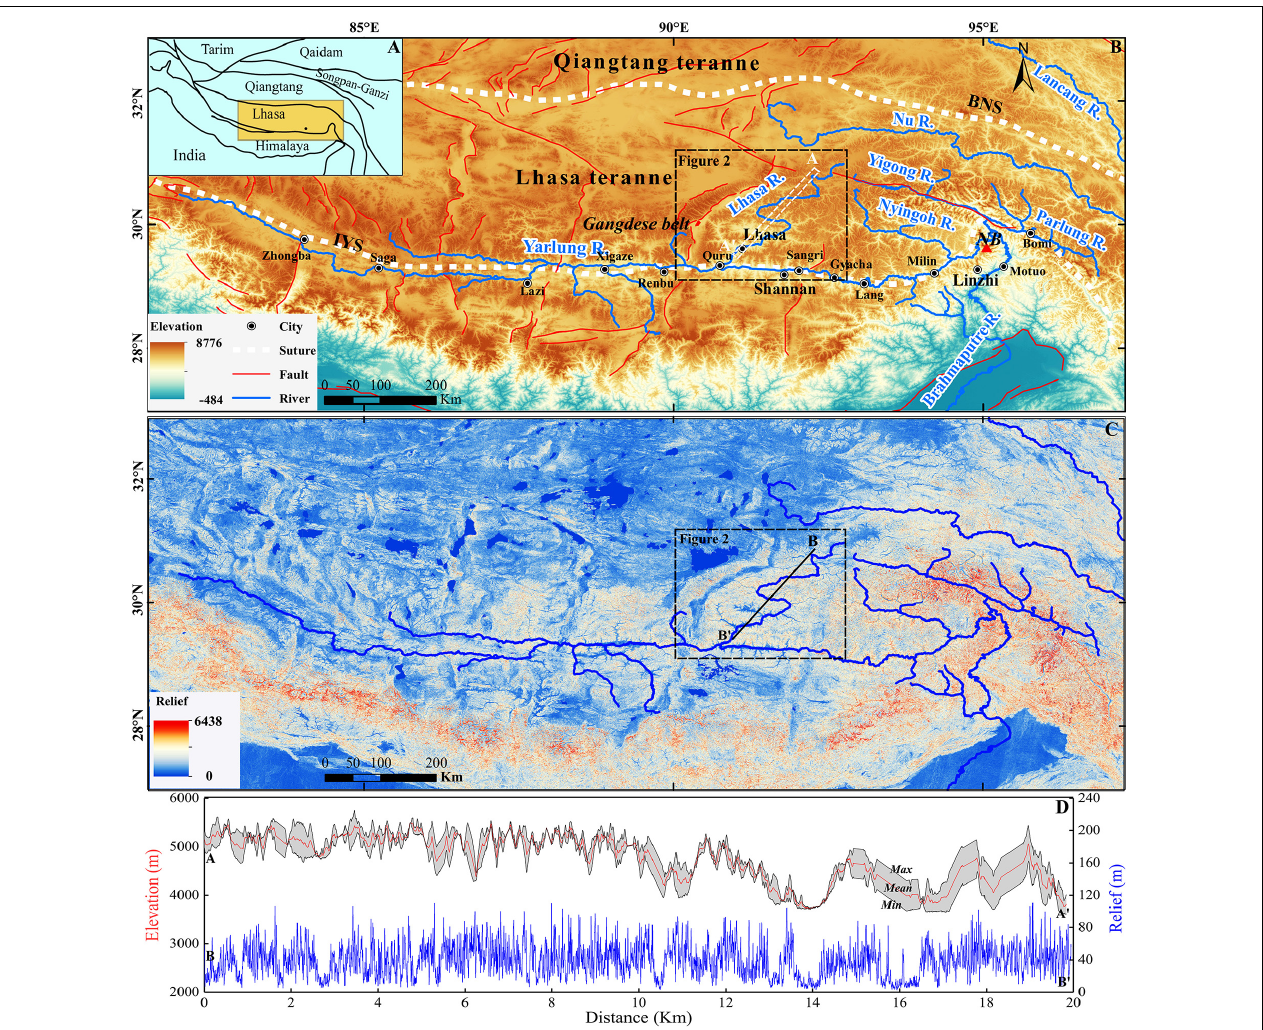
FIGURE 1 | Tectonic frame and regional topography of the southern Tibetan Plateau. (A) Five different east–west-trending terranes in the Tibetan Plateau. Orange rectangular shows the extent of (B) . (B) The main faults and rivers and the topography of the southern Tibetan Plateau. The black box shows the extent of Figure 2 . White dashed box indicates the locations of elevation swath profiles in (D) . IYS, Indus-Yarlung suture zone; BNS, Bangong-Nujiang suture zone; NB: Namche Barwa. (C) Topographic relief of the southern Tibetan Plateau. The black line indicates the locations of the relief profile in (D) . (D) Relief and elevation swath profiles across the Lhasa River